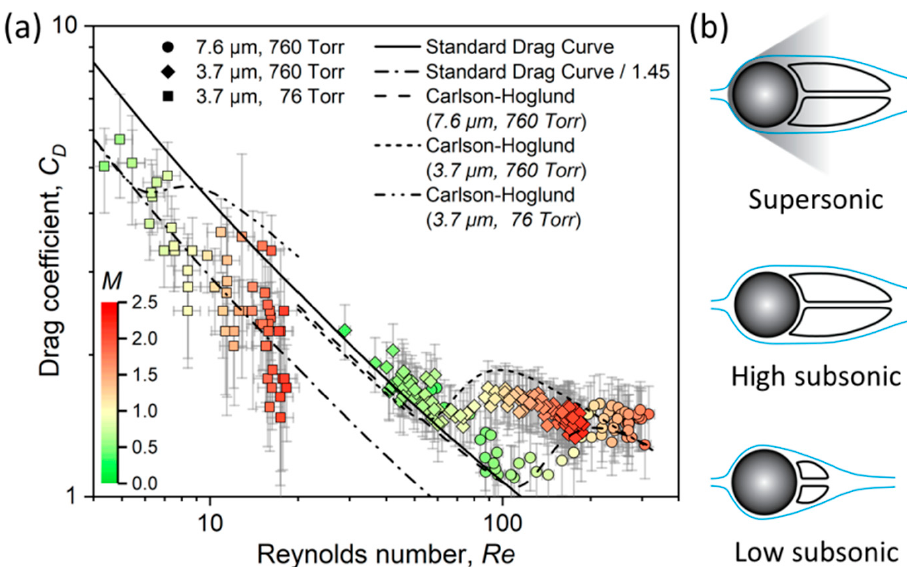
Figure 3. ( a ) Drag coefficient, C D , vs. Reynolds number, Re , for the three experimental conditions. Data points are colored according to M . Previously published models are provided for comparison. Error bars correspond to a 95% confidence interval ( ± 2 standard deviations). ( b ) Approximate fluid flow characteristics at supersonic, high subsonic, and low subsonic microsphere velocities. Black lines represent the extents of the recirculation region, while blue lines represent streamlines. A detached bow shock is present in the supersonic condition. Steady flow features are depicted because Re values for nearly all microsphere flights studied in this work fall below the 270–300 range when the onset of unsteady vortex shedding occurs for